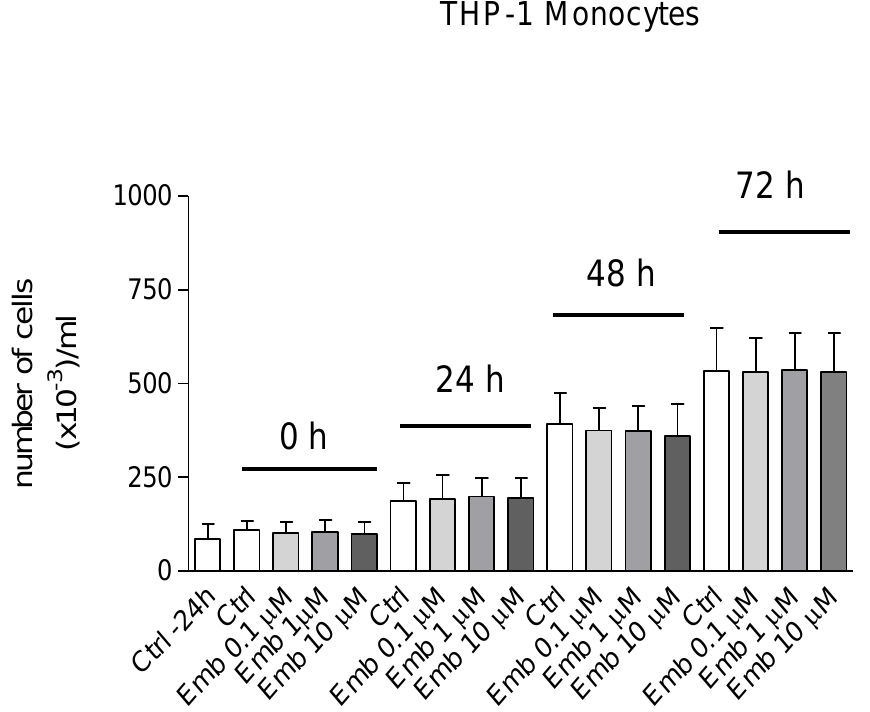
Figure 21. Proliferation curves in the presence of embelin (0.1 – 10 μM) of BV-2 microglia. BV-2 microglia cells were seeded in 60 × 15 mm Petri dishes in 4 mL of the respective medium at appropriate density to reach confluence after 96 h. Cells were stimulated with embelin 24 h from seeding and then counted every 24 h up to confluence. Results are the mean ± SD of 3 different experiments carried out in triplicate. None of the reported results showed significance within the same group.